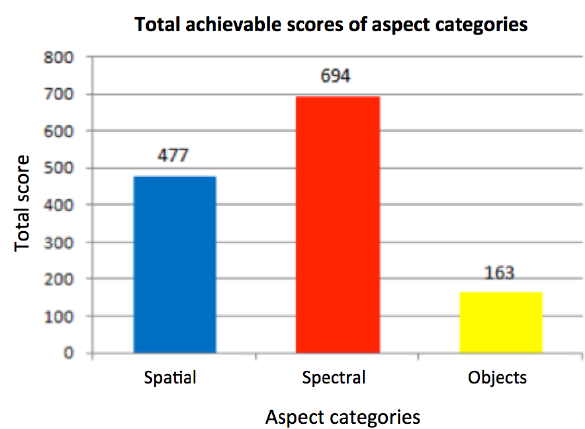
Figure 8. Aspect categories and their total achievable scores